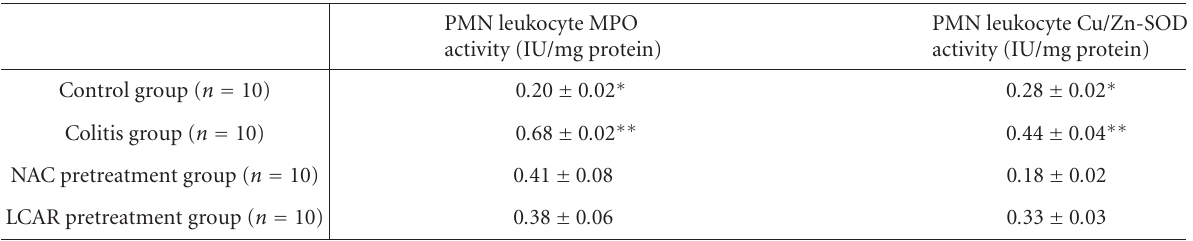
Table 1. The e ff ects of NAC and LCAR on PMN leukocyte MPO and Cu/Zn-SOD activity. Note: data are presented as mean ± SD; PMN, polymorphonuclear; SOD, superoxide dismutase; MPO, myeloperoxidase; NAC, N-acetylcysteine; and LCAR, L-carnitine.